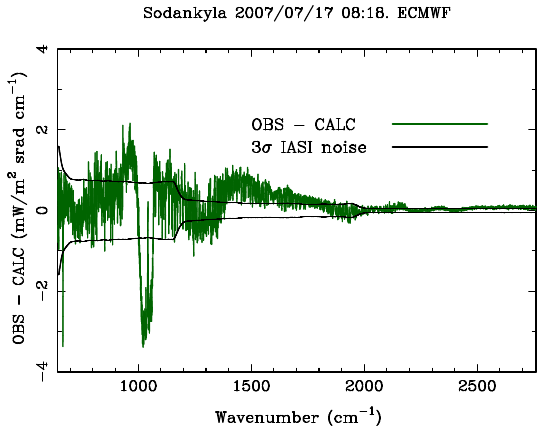
Figure 4. IASI observed minus calculated radiances (OBS-CALC) for the “ECMWF” profile.